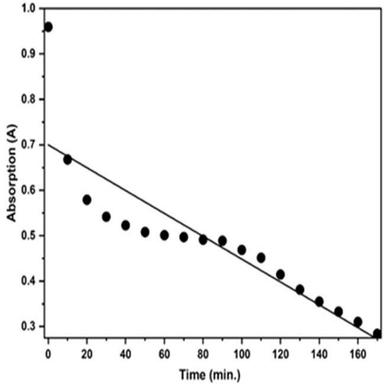
After adding MTZ - ZnMoO4 nanocomposite material (40.0 mg), at 581 nm wavelength, as well as time increased, absorption decreased up to 170 minutes with constant time intervals (10 min.) and the blue colour of the solution was decolourized.